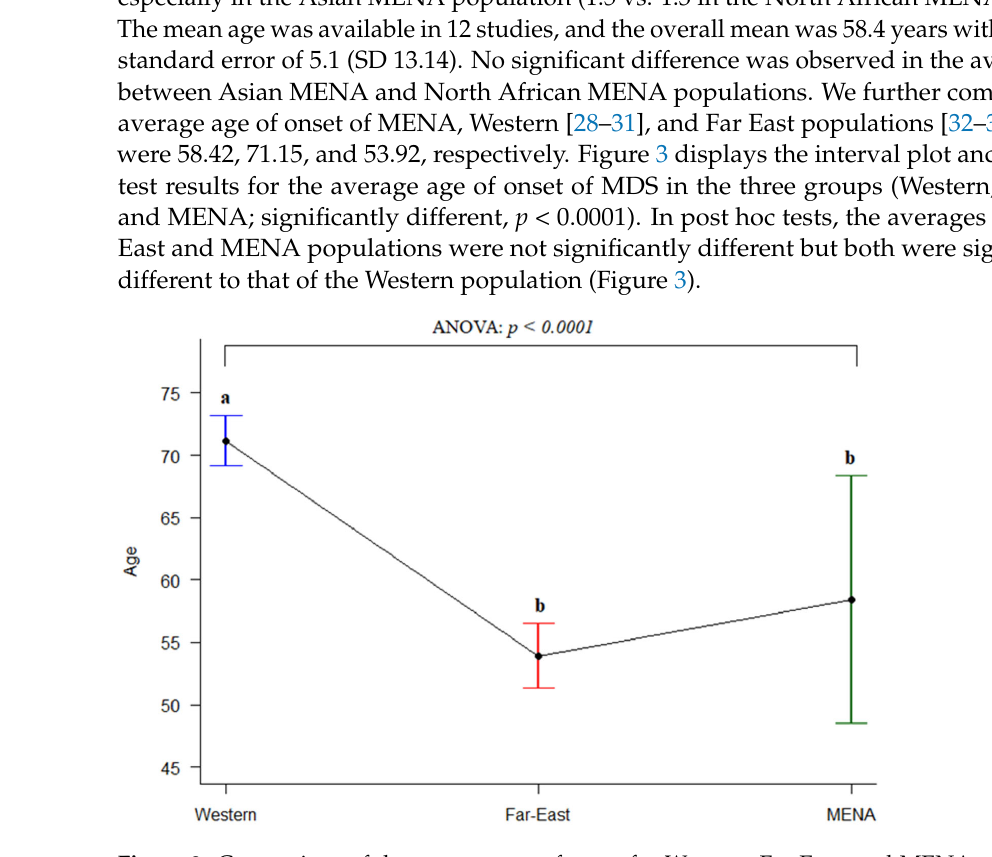
The mean hemoglobin (Hb) was available in ten studies representing 964 patients. The pooled mean Hg was 8.4 g/dL. The lowest mean Hb was 6.8 g/dL and the highest 10.3 g/dL. The mean platelet count was reported in nine studies representing 870 patients and ranged from 77 to 325 × 103/µL; the mean platelet count was 90 × 103/µL. The mean WBC count was reported in six studies representing 694 patients, and the mean pooled WBC was 5 × 103/µL. Data on cytopenia at presentation were only available for 359 patients in five studies. Unicytopenia was seen in 137 patients (38.2%), bicytopenia in 99 patients (27.6%), pancytope- nia in 122 patients (34%), and no cytopenia in only 1 patient (0.3%). Bone marrow blasts were reported in 191 patients in four studies. Most patients (70.2%) had <5% bone marrow blasts, followed by 10% blasts in 35 (18.3%) and 15% blast in 22 patients (11.5%) (Table 3). Table 3. Cytopenia and bone marrow blast values at diagnosis. Clinical Parameter